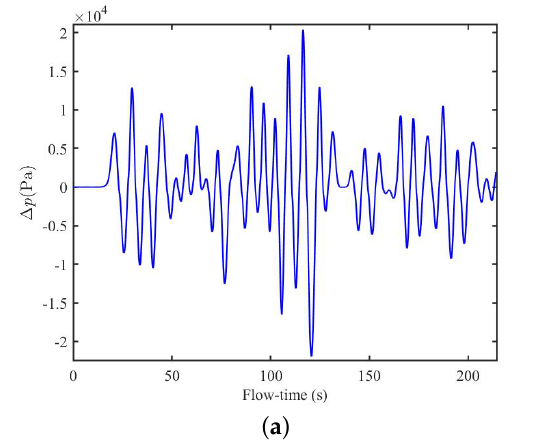
Figure 18. Variation in the ( a ) pressure drop, and ( b ) flow rate vs. the flow-time, with H s = 1.23 m and ω p = 0.811 Hz.